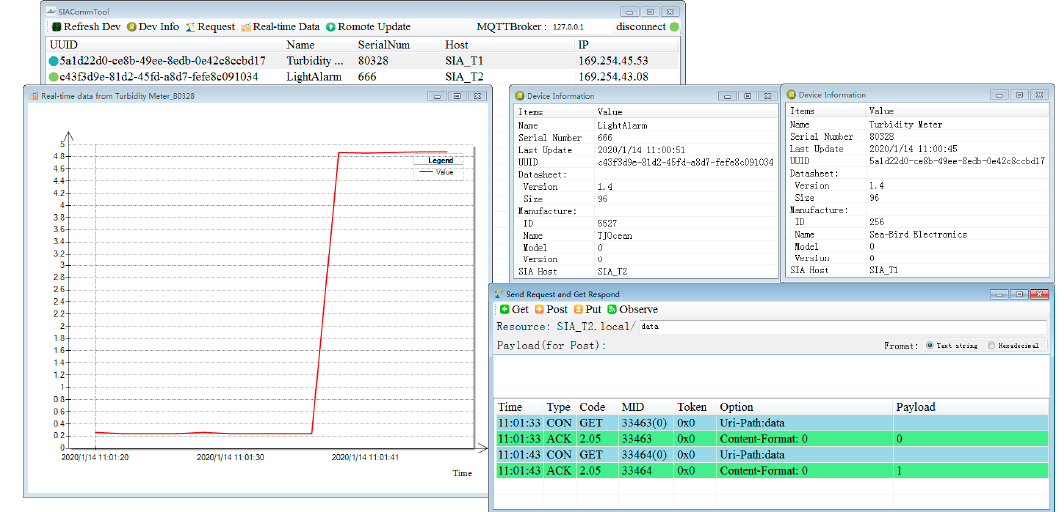
Figure 11. Screenshot of the PC software during the laboratory test.